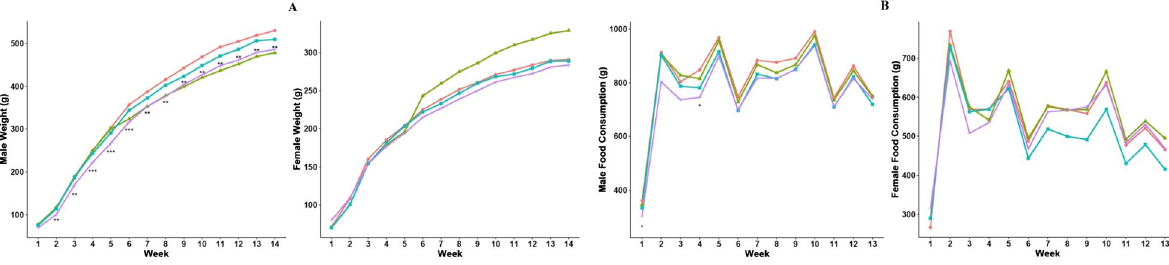
Fig. 1 Changes in body weight and food consumption in male and female rats during 90 days of exposure to the maleic acid polymer scale inhibitor. Body weight and food consumption were measured every 2 weeks. A Changes in body weight. B Changes in food consumption. All values are expressed as the mean SD per group. ( n 20, 10 male and 10 female). The Shapiro–Wilk test was used to assess normality, and Bartlett’s ± = test was used to assess homogeneity of variance. Dunnett’s test was used in the case of homoscedasticity and a normal distribution, and the Wilcoxon rank–sum test was used in the case of heteroscedasticity or a skewed distribution for statistical analysis comparing with the control group.